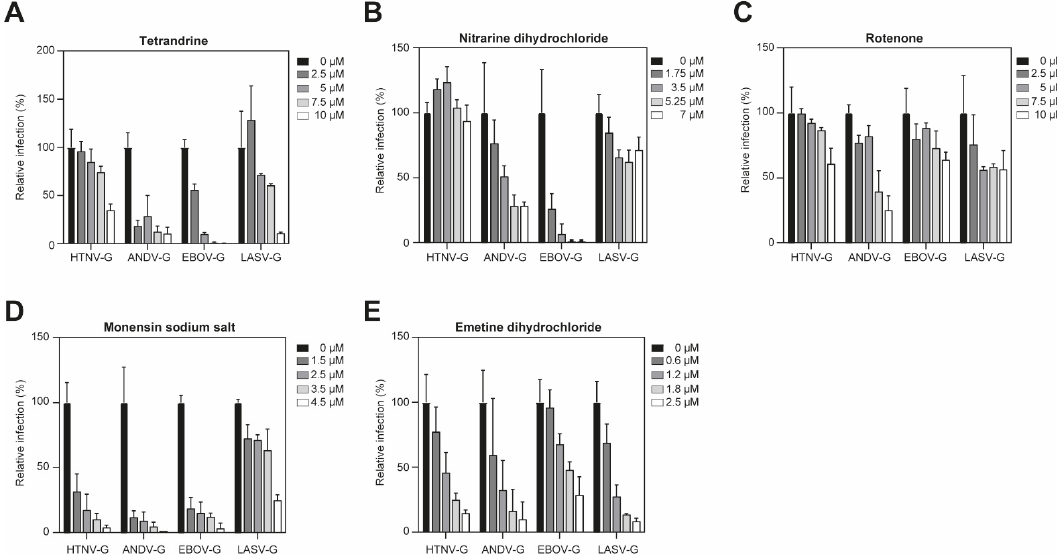
Figure 4. Tetrandrine ( A ), nitrarine dihydrochloride ( B ), rotenone ( C ), monensin sodium salt ( D ) and emetine dihydro- chloride differentially ( E ) affect infection of VSV* Δ G-Luc(HTNV), VSV* Δ G-Luc(ANDV), VSV* Δ G-Luc(EBOV) and VSV* Δ G-Luc(LASV) pseudotypes in A549 cells. A549 cells were pre-treated with different compounds at increasing con- centrations for 45 min at 37 °C, followed by infection with the pseudoviruses in the presence of the drug for 90 min at 200 IU/well. Complete medium with 20 mM ammonium chloride was added and incubated for 16 h. The infection levels were assessed by counting the EGFP-positive infected cells. Cell toxicity was assessed in parallel on uninfected cells by measuring ATP content. Data are means + SD ( n = 3).